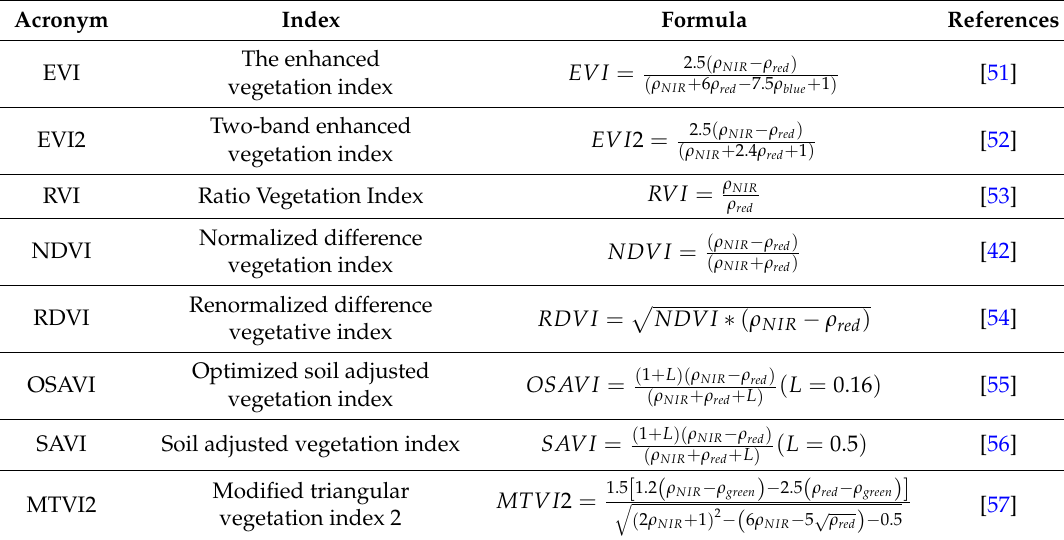
Table 4. Vegetation indices assessed in the study.